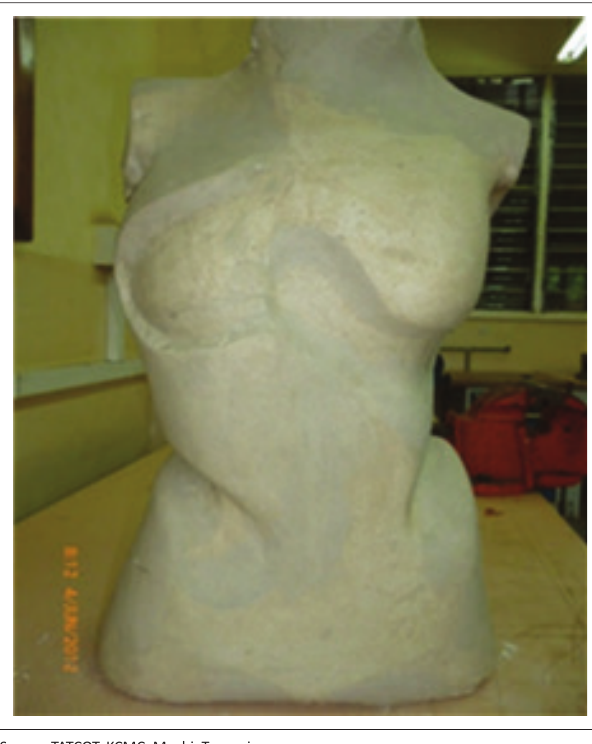
FIGURE 3: Plaster of Paris (POP) positive casts modified to fabricate spinal orthosis.